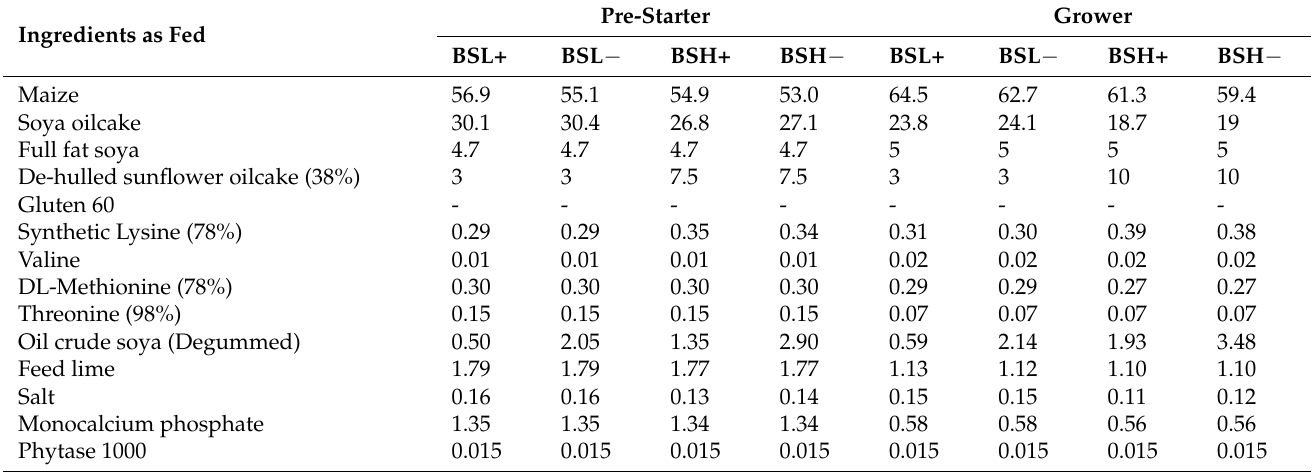
Table 1. Composition and calculated nutrients (%) of the basal diets for the pre-starter (1–9 d) and grower phase (10–20 d).